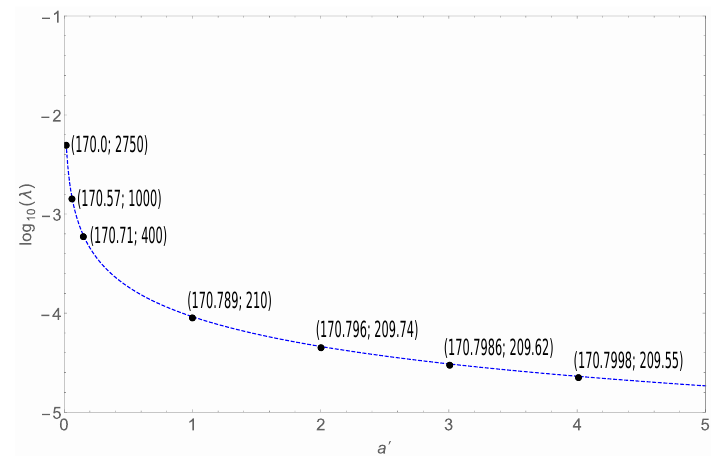
Figure 6 . log ( λ ) vs a 0 . The blue dashed line is obtained for the solution of the RGEs with M t 10 ranging from 170 . 00 GeV (leftmost point) to 170 . 80 (for the limit a 0 → ∞ ). Throughout the curve a series of benchmark points are highlighted, with the first number in parenthesis representing the value of the top quark pole mass M t employed to solve the threshold corrections in the electroweak scale parameters, while the second number represents the value of the high energy scale non- minimal coupling ξ ( M P ) , required to recover the measured amplitude of scalar perturbations ( A s = 2 . 101 × 10 − 9